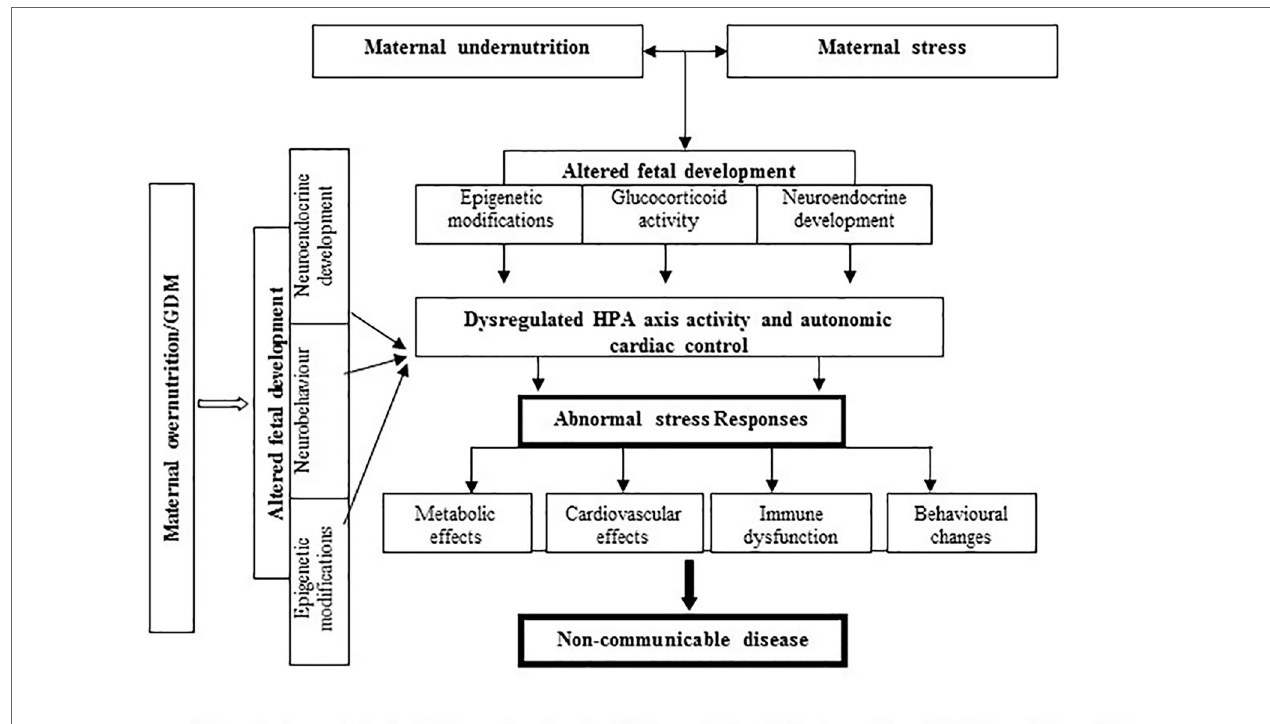
FIGURe 1 | Proposed pathways linking prenatal maternal nutrition and altered stress reactivity in